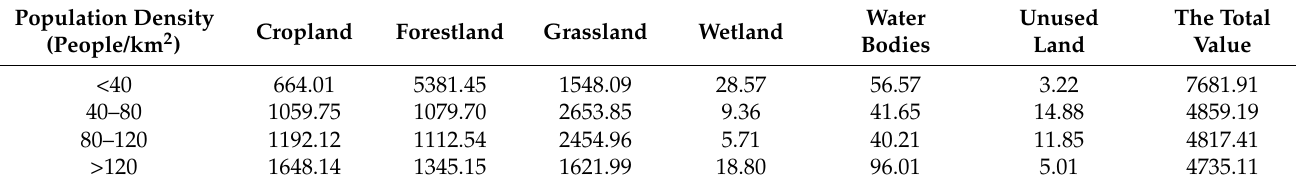
Table 10. ESV per unit area of different population densities. Unit: yuan/hm 2